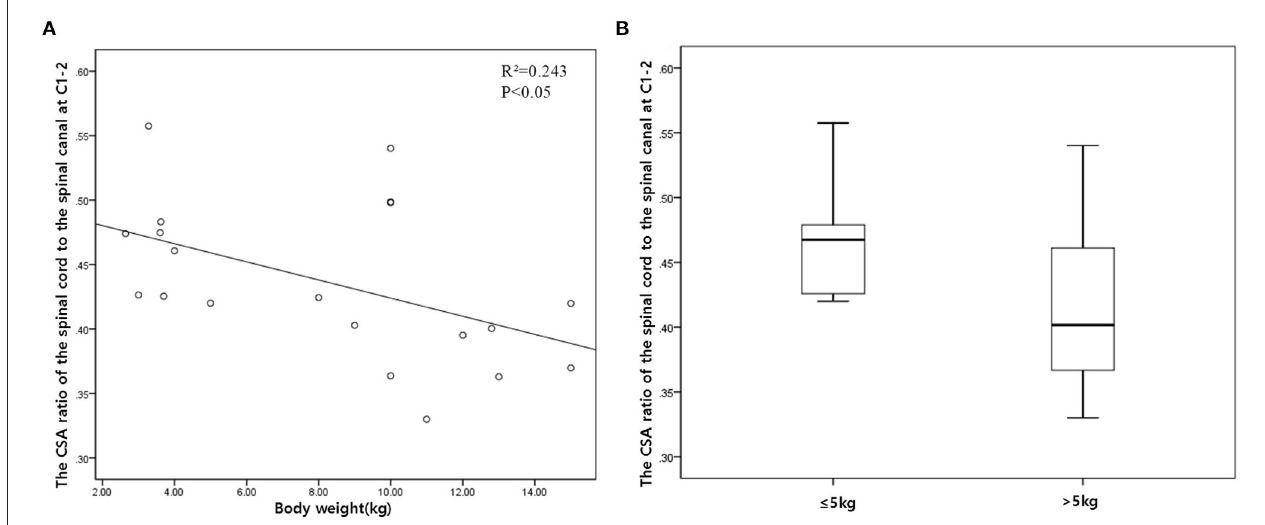
FIGURE 3 | (A) Scatter plot and linear regression for the cross-sectional area (CSA) ratio of the spinal cord to the spinal canal (the CSA ratio) in relation to body weight at C1–C2. (B) Box plot of the CSA ratio at C1–C2 compared by dividing the dogs into two groups: dogs ≤ 5kg (eight dogs) and dogs > 5kg (12 dogs).